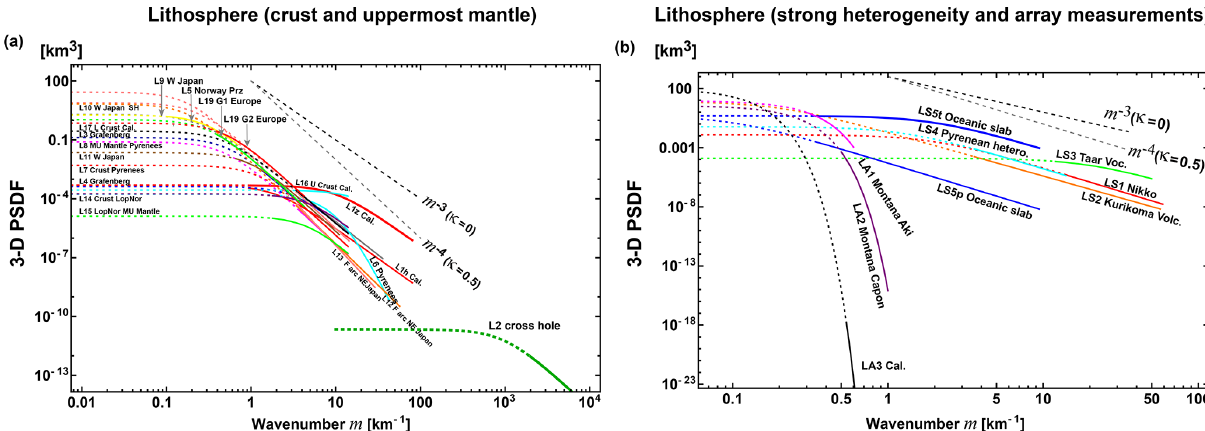
Figure 3. 3-D PSDF vs. wavenumber for (a) the lithosphere (the crust and uppermost mantle), (b) strong heterogeneities and array data analyses in the lithosphere. See labels in Table 2.